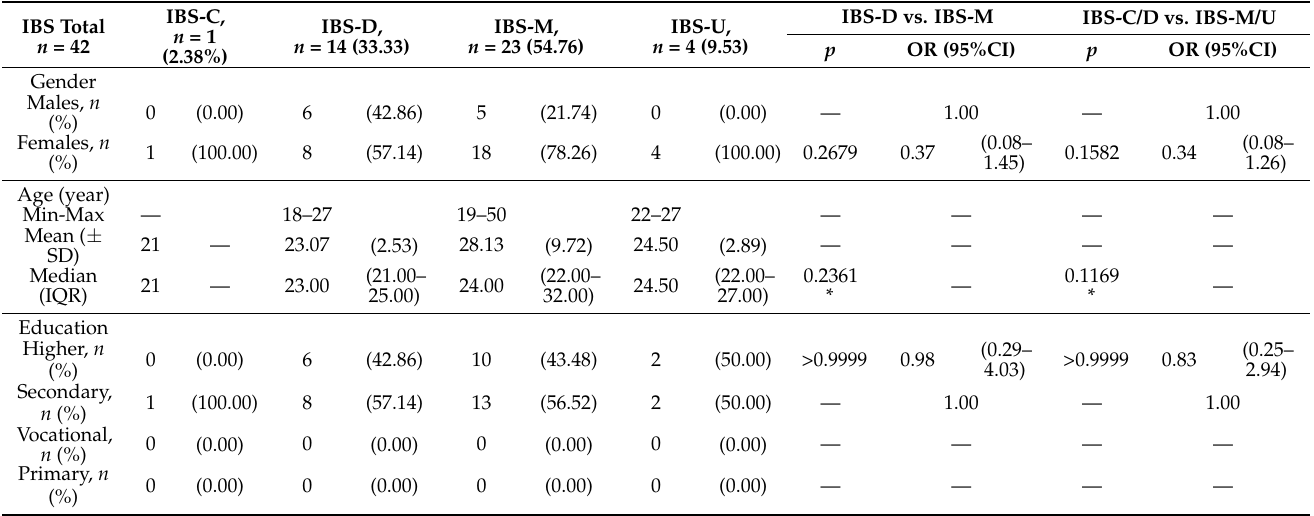
95%CI—95% confidence interval; IBS—Irritable bowel syndrome; IBS-C—constipation-predominant IBS; IBS-D—diarrhea-predominant IBS; IBS-M—mixed IBS; IBS-U—unclassified IBS; IQR—interquartile range; OR—odds ratio; p — p value in two-sided Fisher’s exact test or two-sided Mann—Whitney U test (marked with *); SD—standard